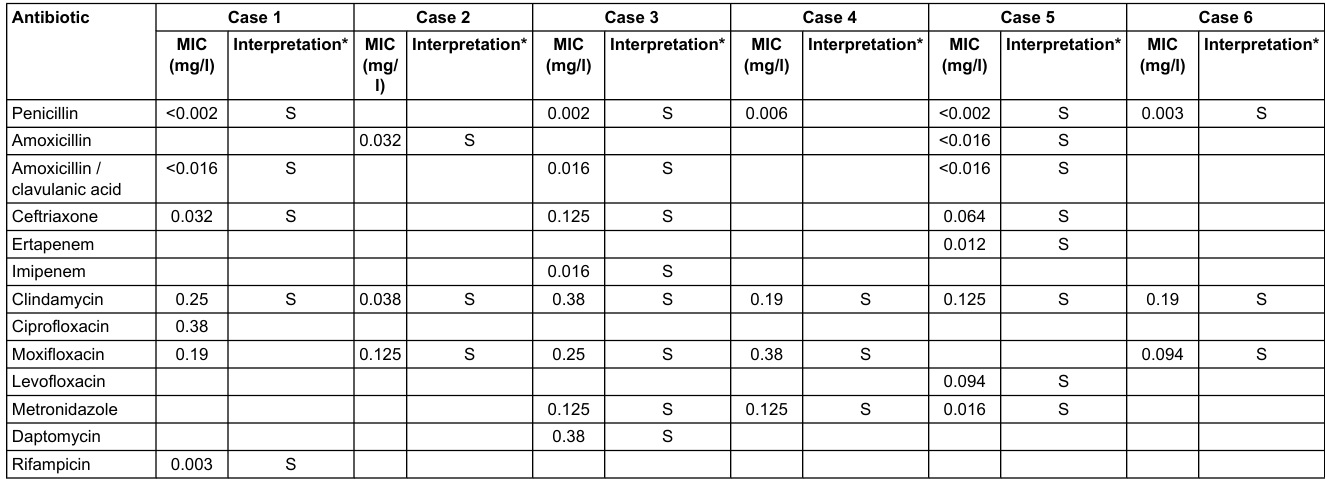
Table 2: Susceptibility testing of clinical isolates of Parvimonas